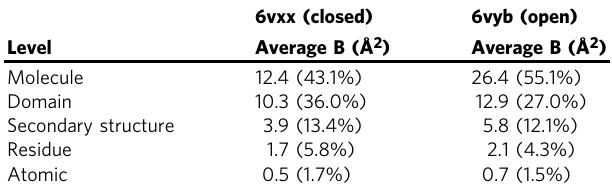
Table 1 Distribution of B-factors for ECHT decompositions of SARS-CoV-2 surface glycoprotein (6vxx & 6vyb). The columns contain the average B-factors for each ECHT level in both Å 2 and as a percentage of the total